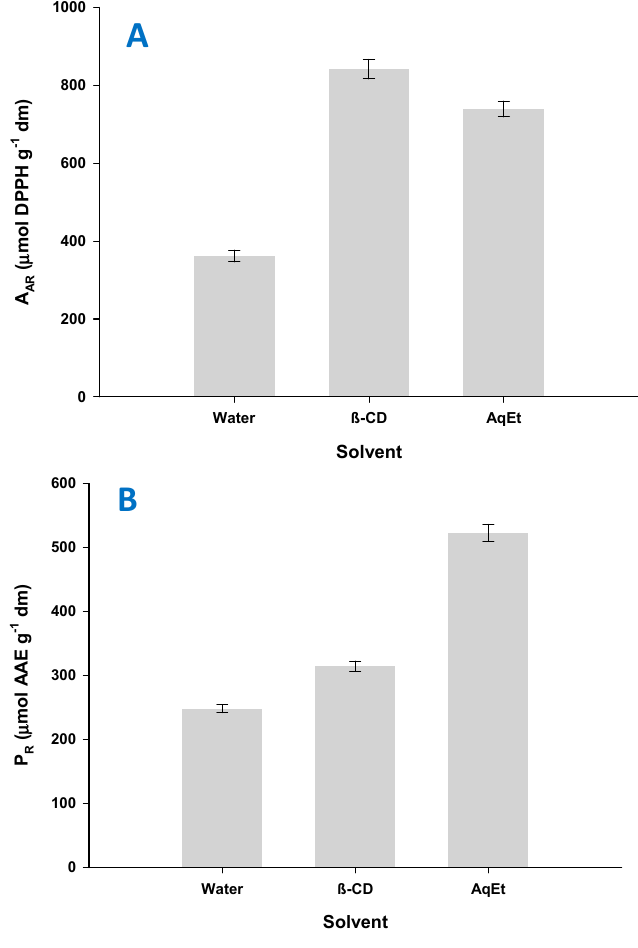
Figure 7. Bar plot showing AAR ( A ) and PR ( B ) of the extracts produced with the extraction media tested. Extractions with β -CD were performed under optimized conditions ( C CD = 1.5%, t us = 30 min, R L/S = 90 mL g − 1 ), under stirring at 900 rpm, for 180 min. The same conditions (except for the addition of β -CD) were applied to the extractions with water and 60% aqueous ethanol (AqEt).